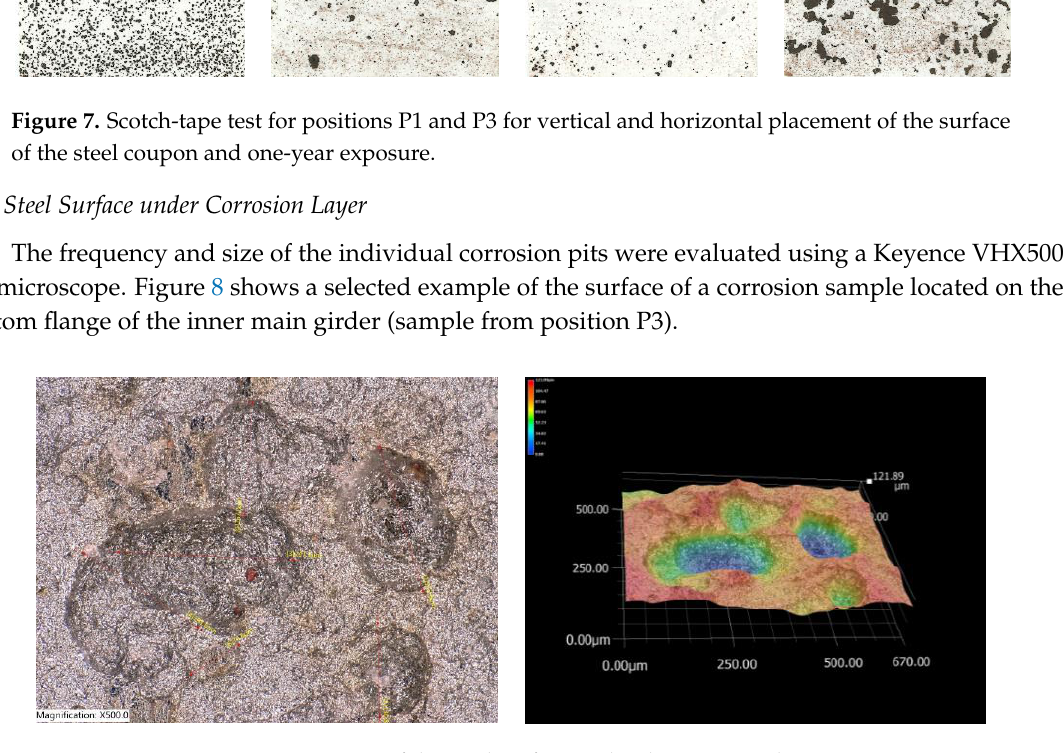
Figure 7. Scotch-tape test for positions P1 and P3 for vertical and horizontal placement of the surface of the steel coupon and one-year exposure.